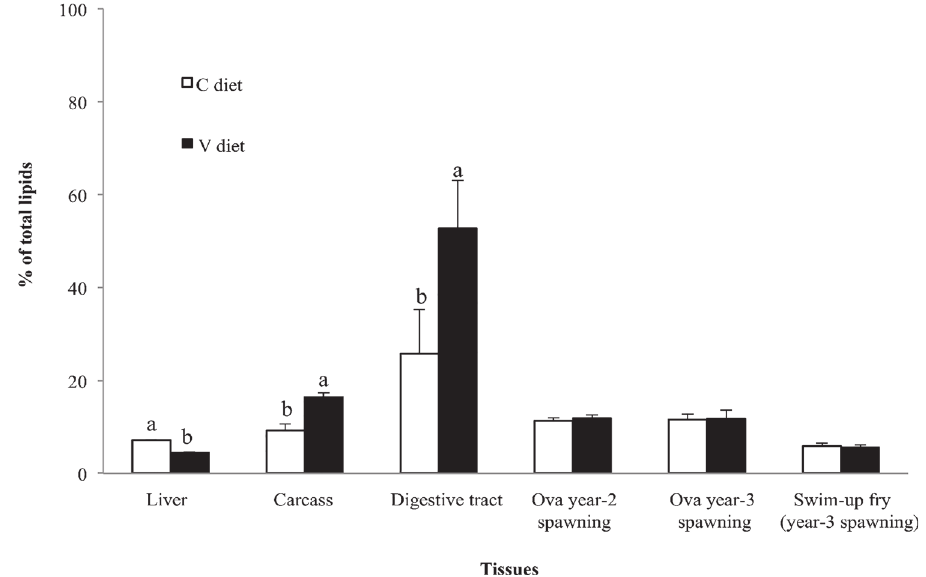
Fig 2. Total lipid content in female tissues, ova and swim-up fry. Data are presented as mean ± SD. p-values were produced by independent sample t-test. Different letters indicates significant differences ( p-value <